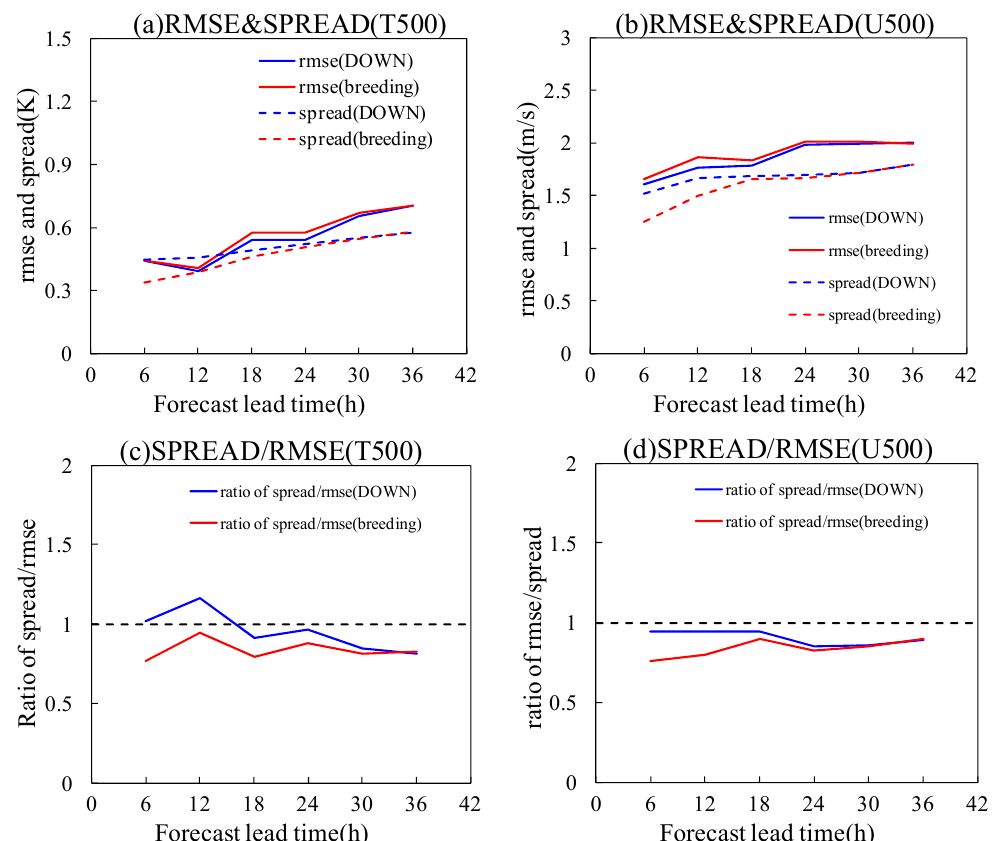
Figure 6. RMSE of the ensemble mean, ensemble spread and their ratio as a function of the forecast lead time for the Breeding and Down schemes. ( a ) RMSE and spread for T500; ( b ) RMSE and spread for U500; ( c ) ratio of the spread and RMSE for T850; and ( d ) ratio of the spread and RMSE for U850.